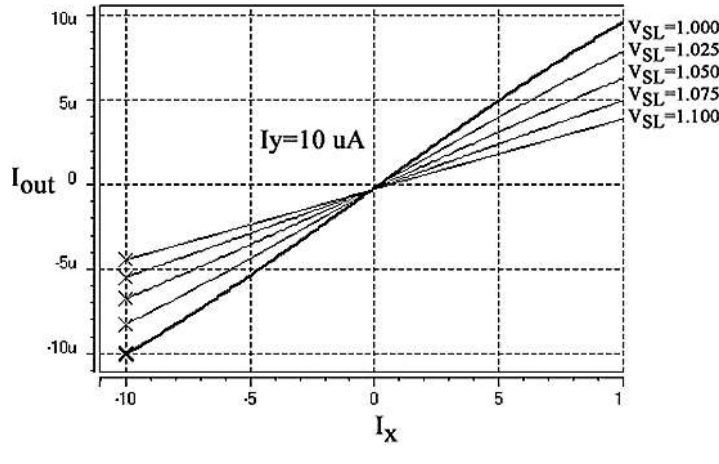
Figure 5. VSL effect on the output current slope